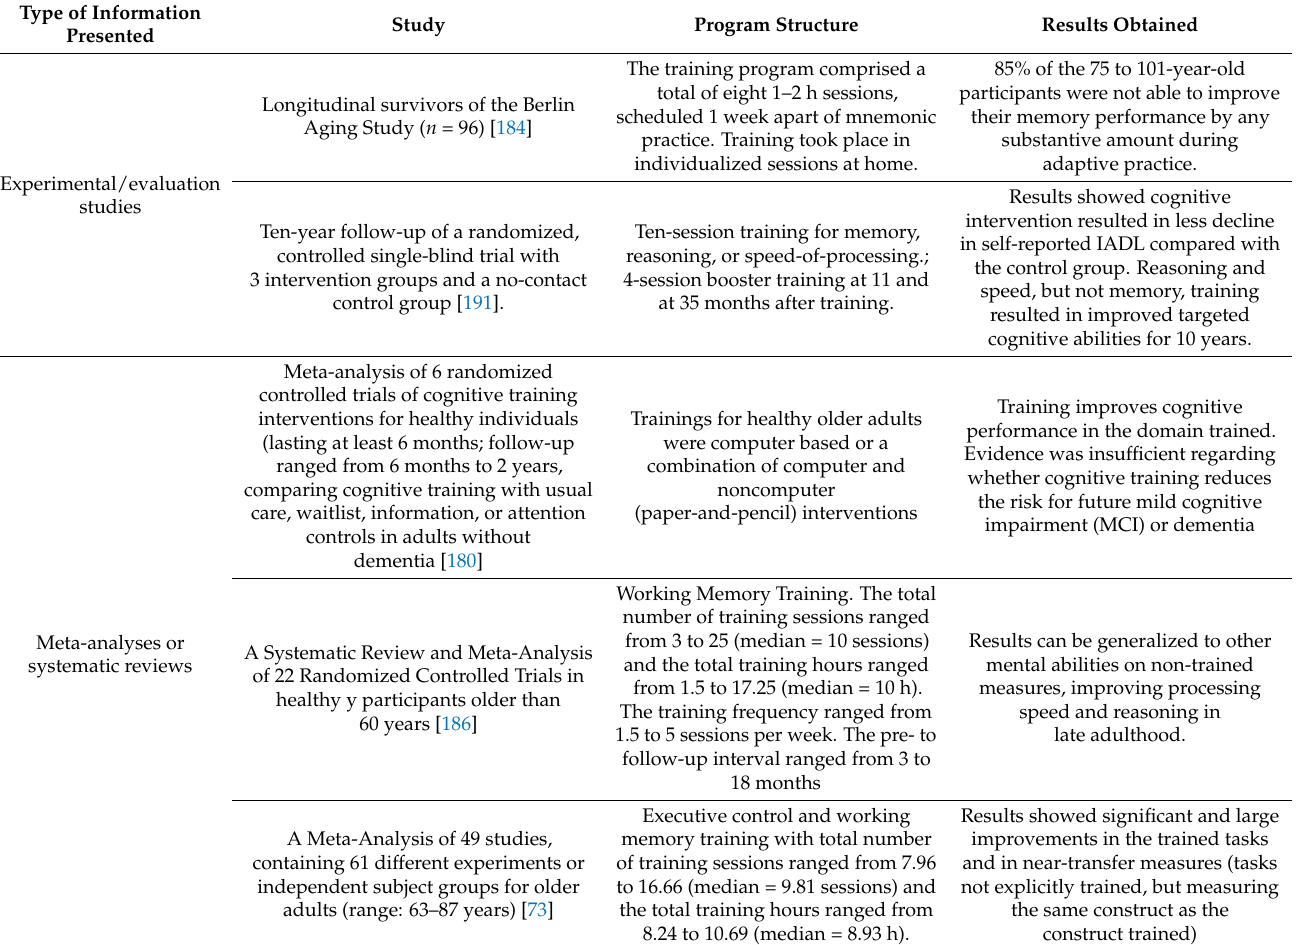
Table 2. Examples of experimental/program evaluation and meta-analyses studies of cognitive training for enhancing and promoting cognitive